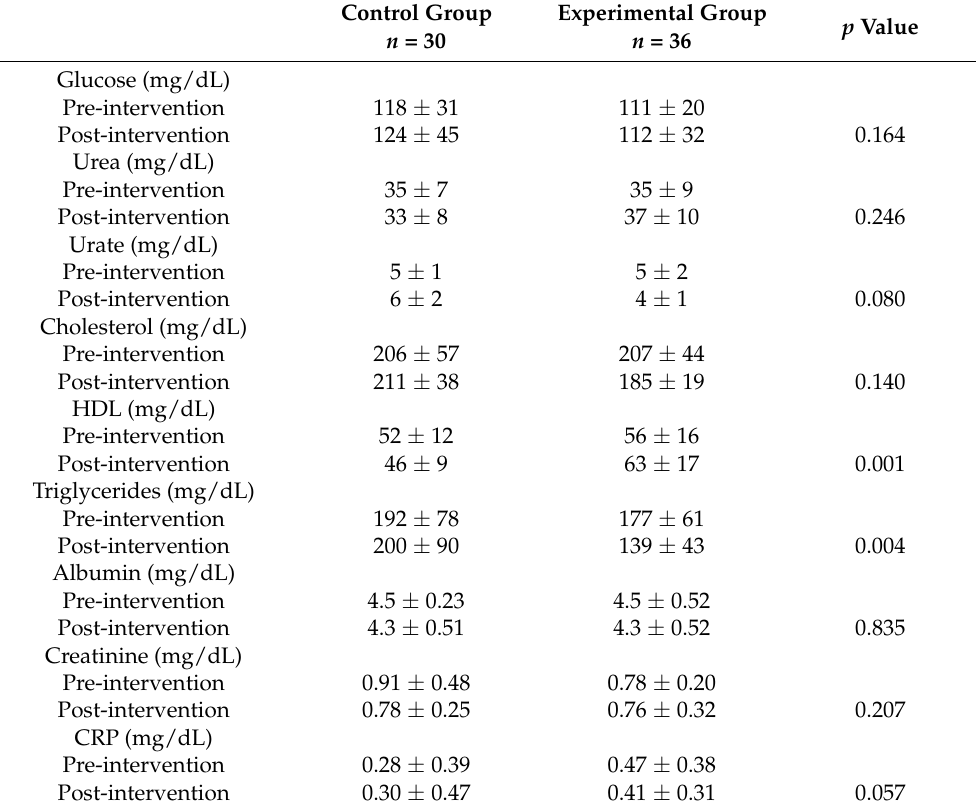
Table 5. Pre and post-intervention biochemical parameters by group.